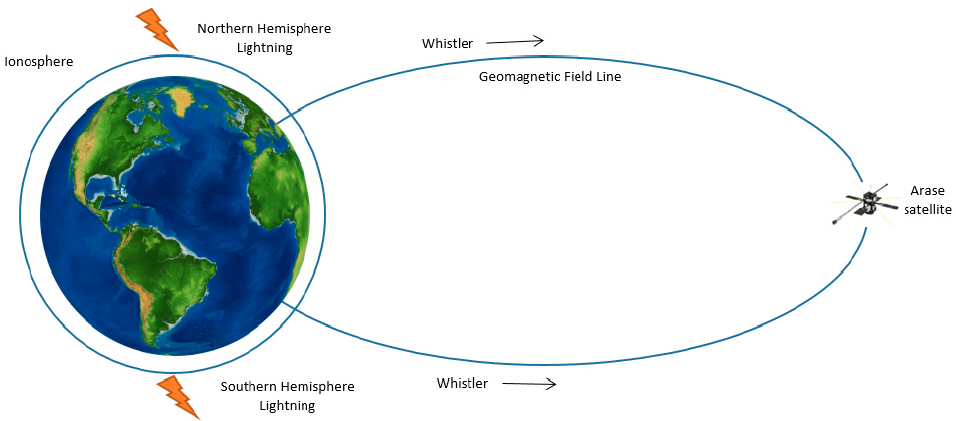
Figure 2. Propagation path of a lightning whistler. 144